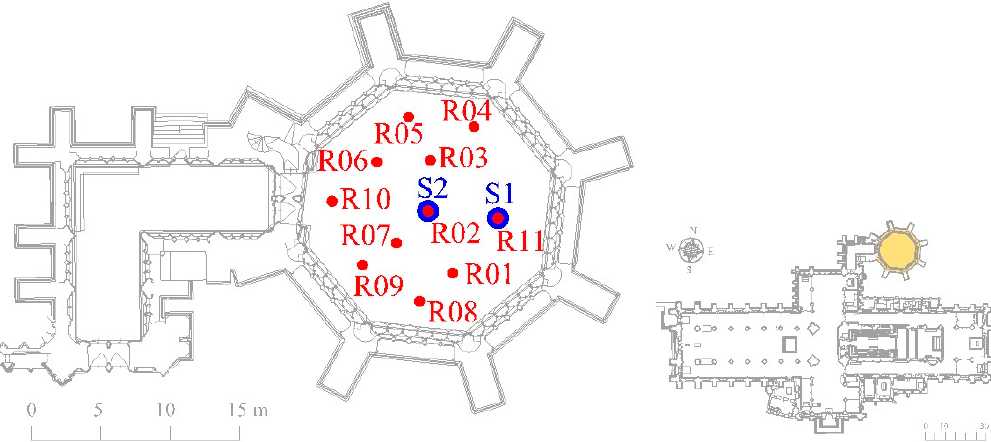
Figure 1. Floor plan of the York Minster’s Chapter House with the source (S) and receiver (R) positions set for the acoustic measurements. The complete floor plan of the Minster is included for showing its location. Table 1. Geometrical data of the York Minster’s Chapter